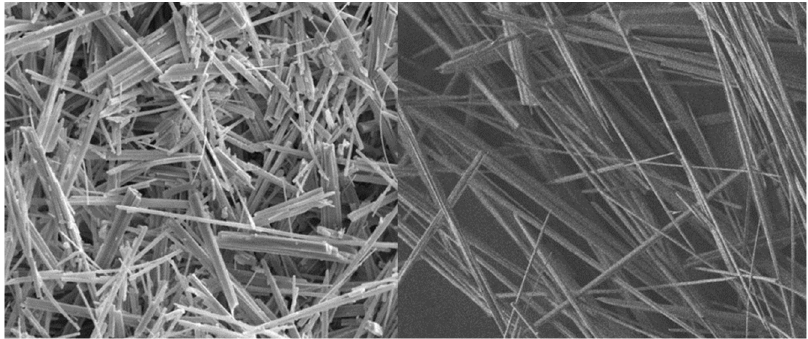
Figure 3. The presentation of calcium sulfate whiskers prepared using PG.